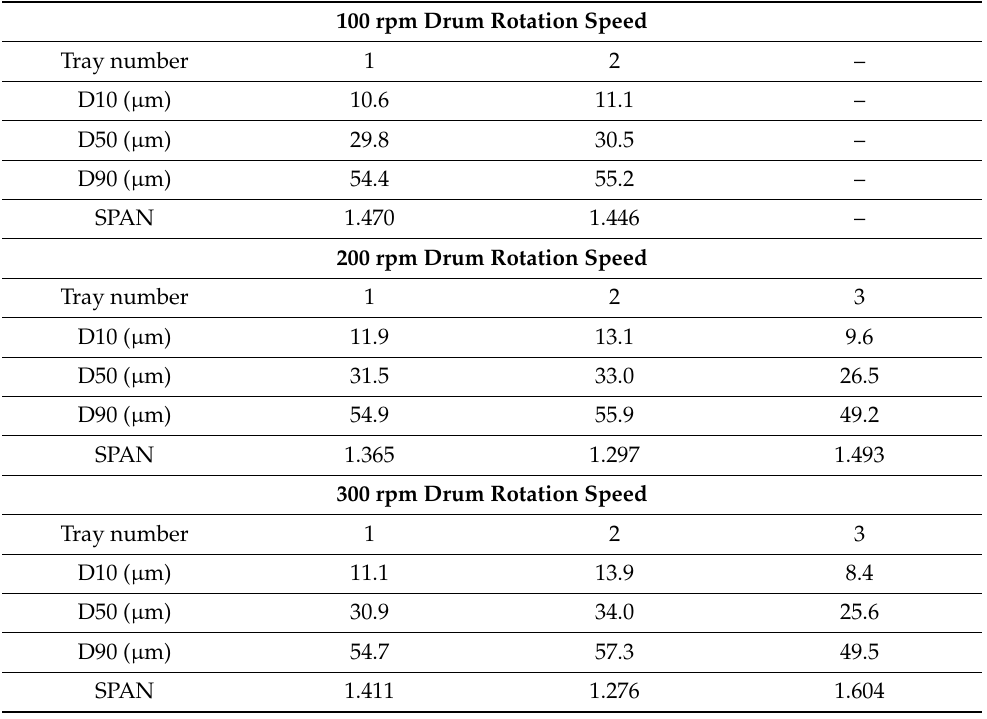
Table 3. Size distribution of ASP-30 powder after separation using the Zeus unit.